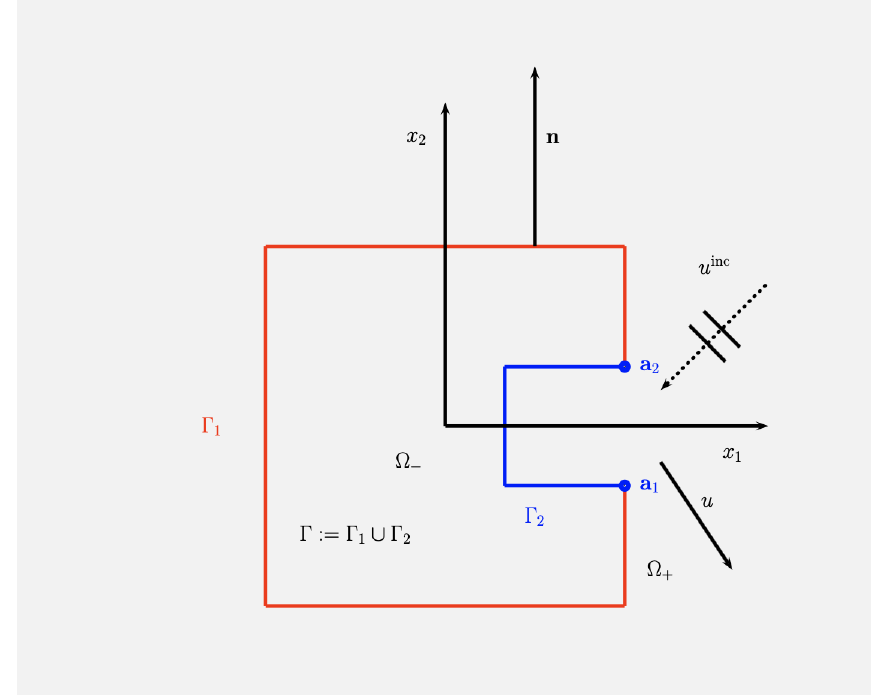
Figure 1. Scattering configuration and